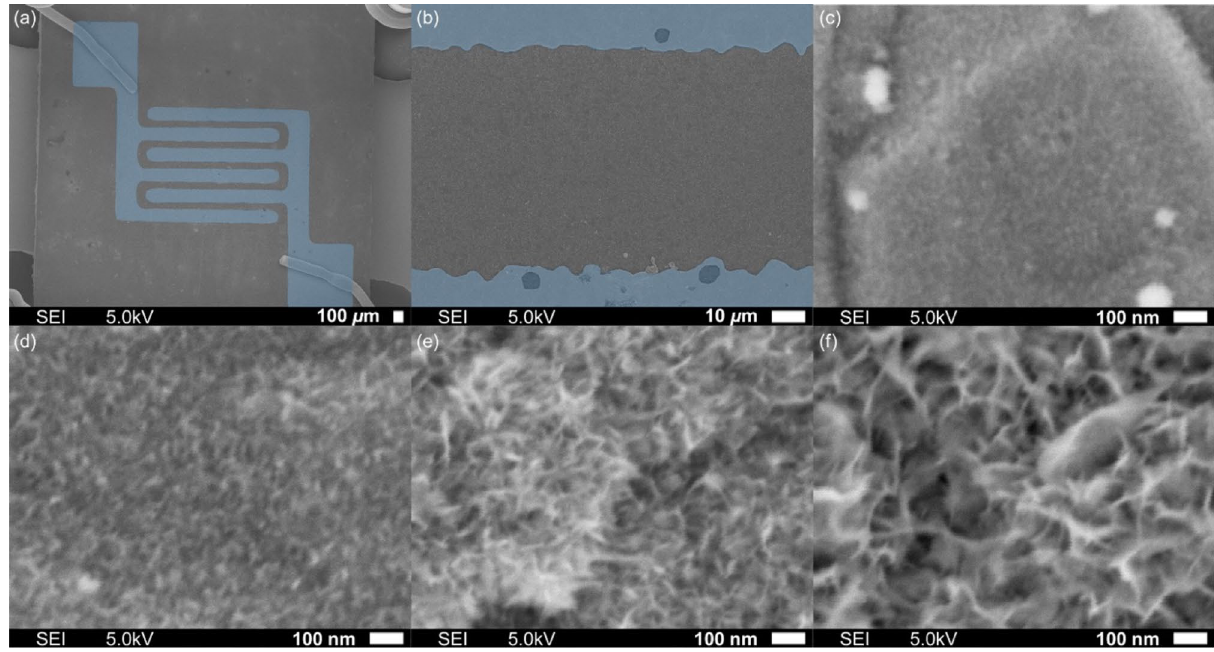
Figure 3. Field emission scanning electron microscopy (FE-SEM) images of the sensor chip (blue area is electrode); ( a ) Pt electrodes on Al 2 O 3 substrate, ( b ) between Pt electrodes, and nanosheet-type of tin oxide after synthesis for ( c ) 0.5 h, ( d ) 1.0 h, ( e ) 3.0 h, and ( f ) 6.0